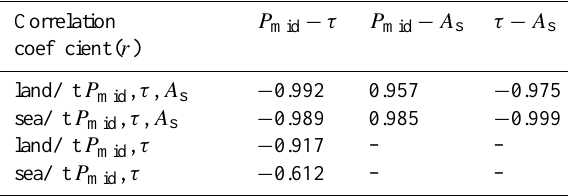
Table 2. A posteriori correlation coefficients ( r ) for a simulated re- trieval of an aerosol layer between 700 and 600hPa with optical thickness at 760nm of 0.3 located over land and over sea. Either mid pressure and optical thickness or mid pressure, optical thick- ness and surface albedo are fitted. Other details are the same as in Figs. 1 and 2.